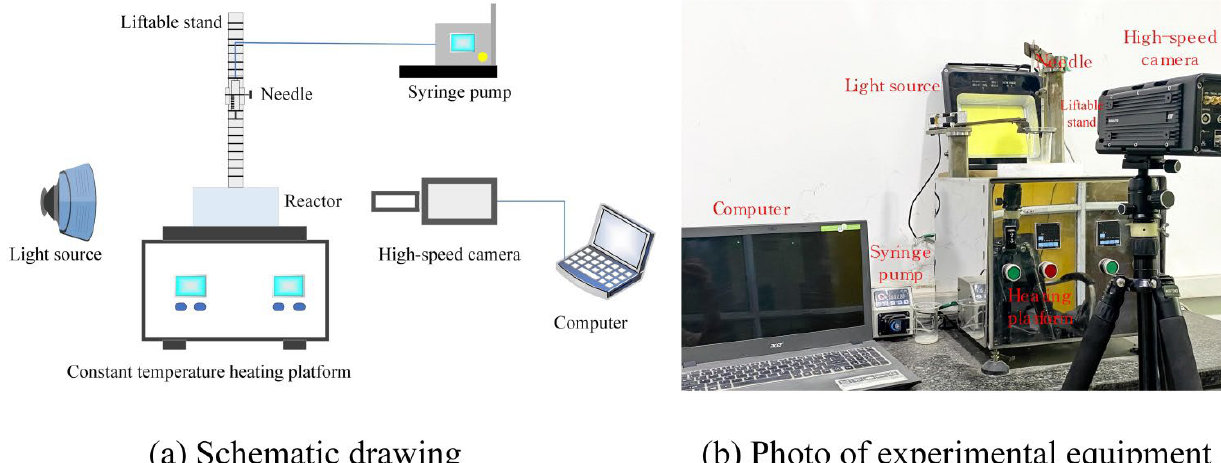
Figure 1. Schematic of experimental